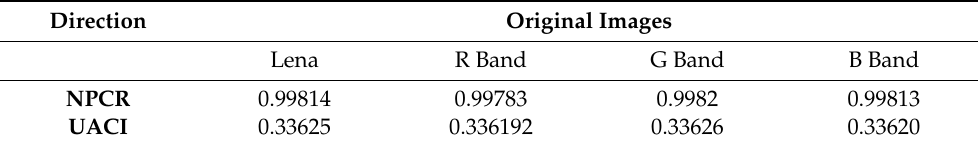
Table 4. Key sensitivity analysis.